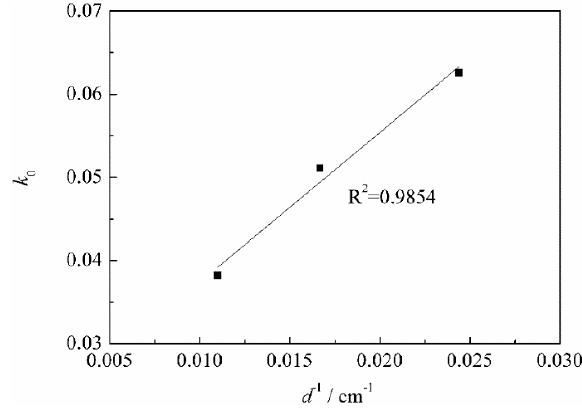
Figure 13. Fitting plots of 1 − 2 α /3 − (1 − α ) 2/3 versus leaching time t at different particle sizes.